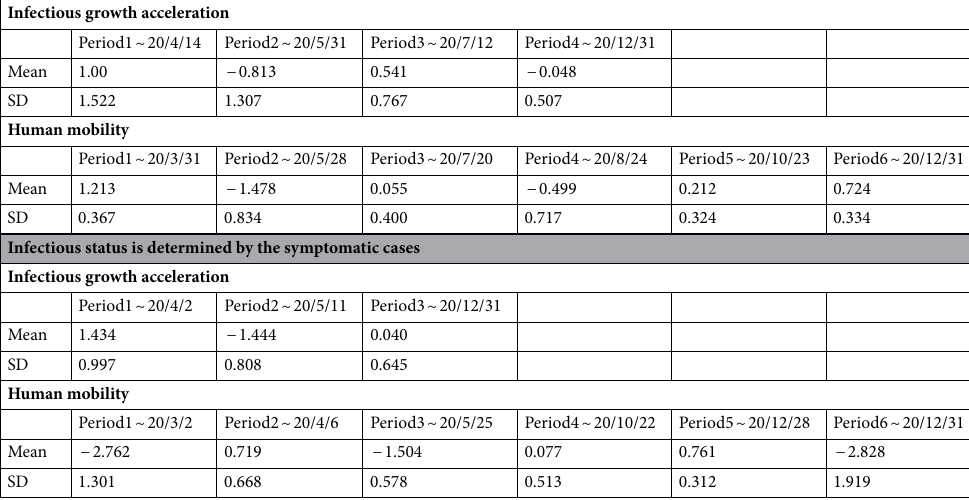
Table 2. Change point detection for infectious growth acceleration and intra-human mobility in Tokyo. LocationMind xPop © LocationMind